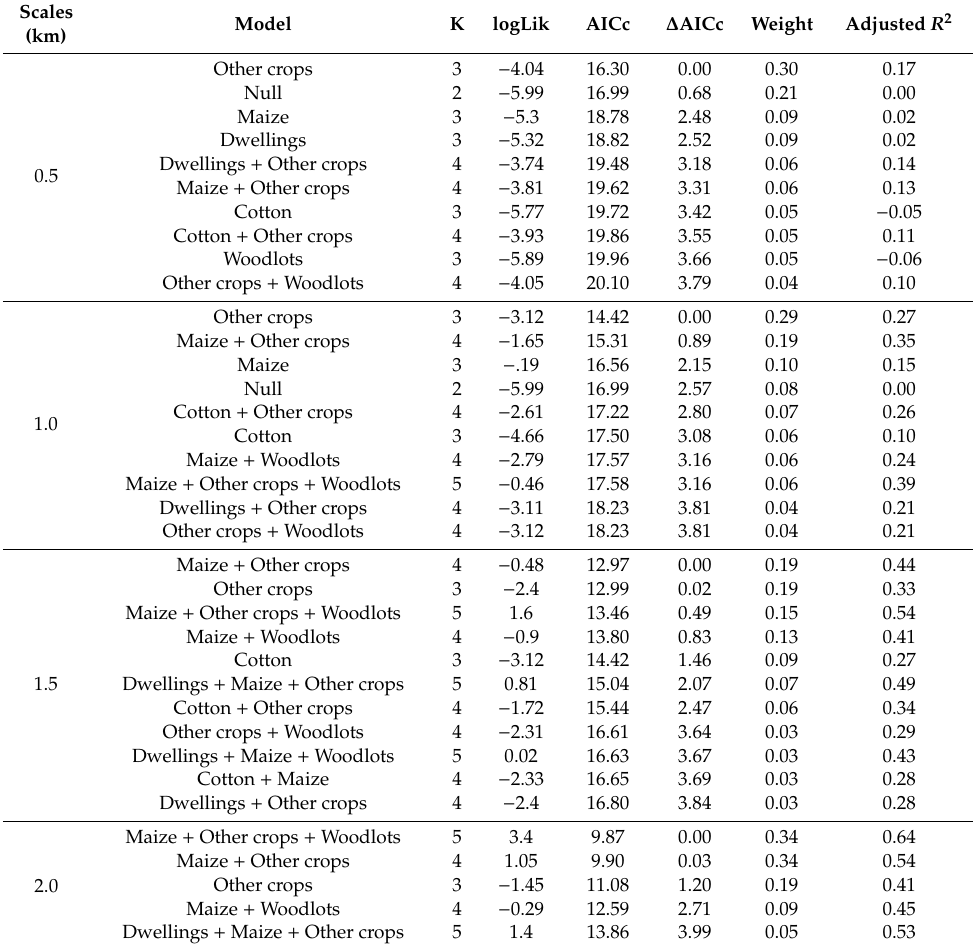
Table 3. List of models that were included in the top model set ( ∆ AICc < 4.0) for model averaging procedure, to infer landscape e ff ects on the abundance of Apolygus lucorum in cotton fields in August. Best models at each scale are indicated in